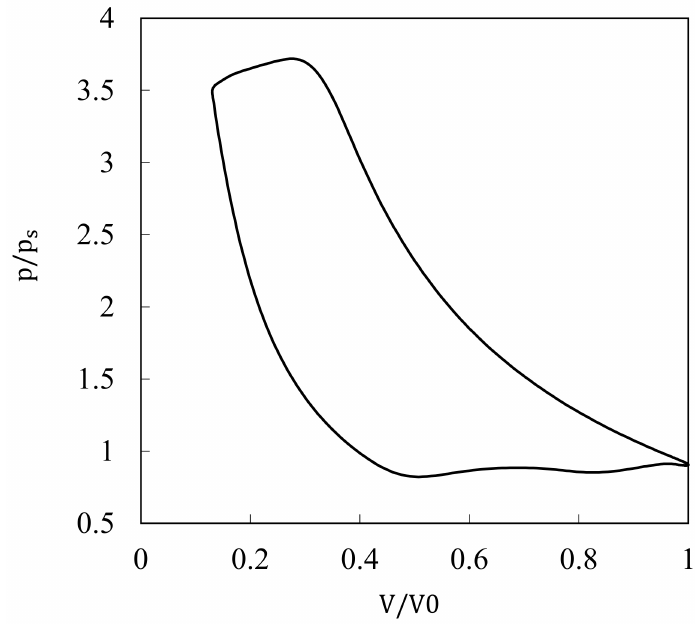
Figure 17. p − V diagram of mild leakage valve with a cracked plate.